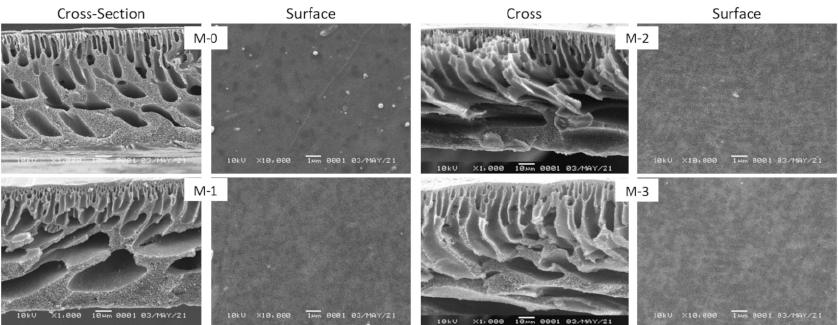
Figure 4. Cross-section and surface SEM images of the membrane